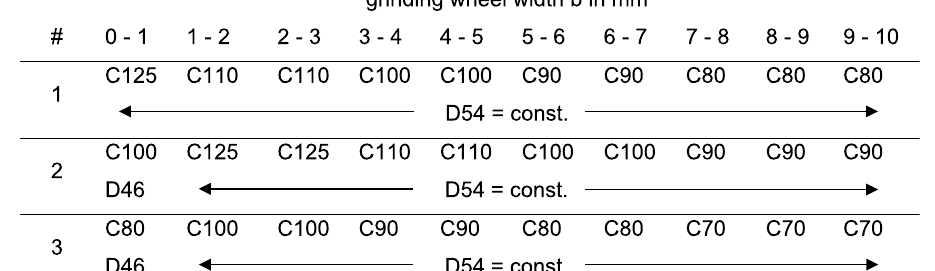
Table 2 Gradients of the used grinding wheels. Grain concentration and grain size are specified according to FEPA